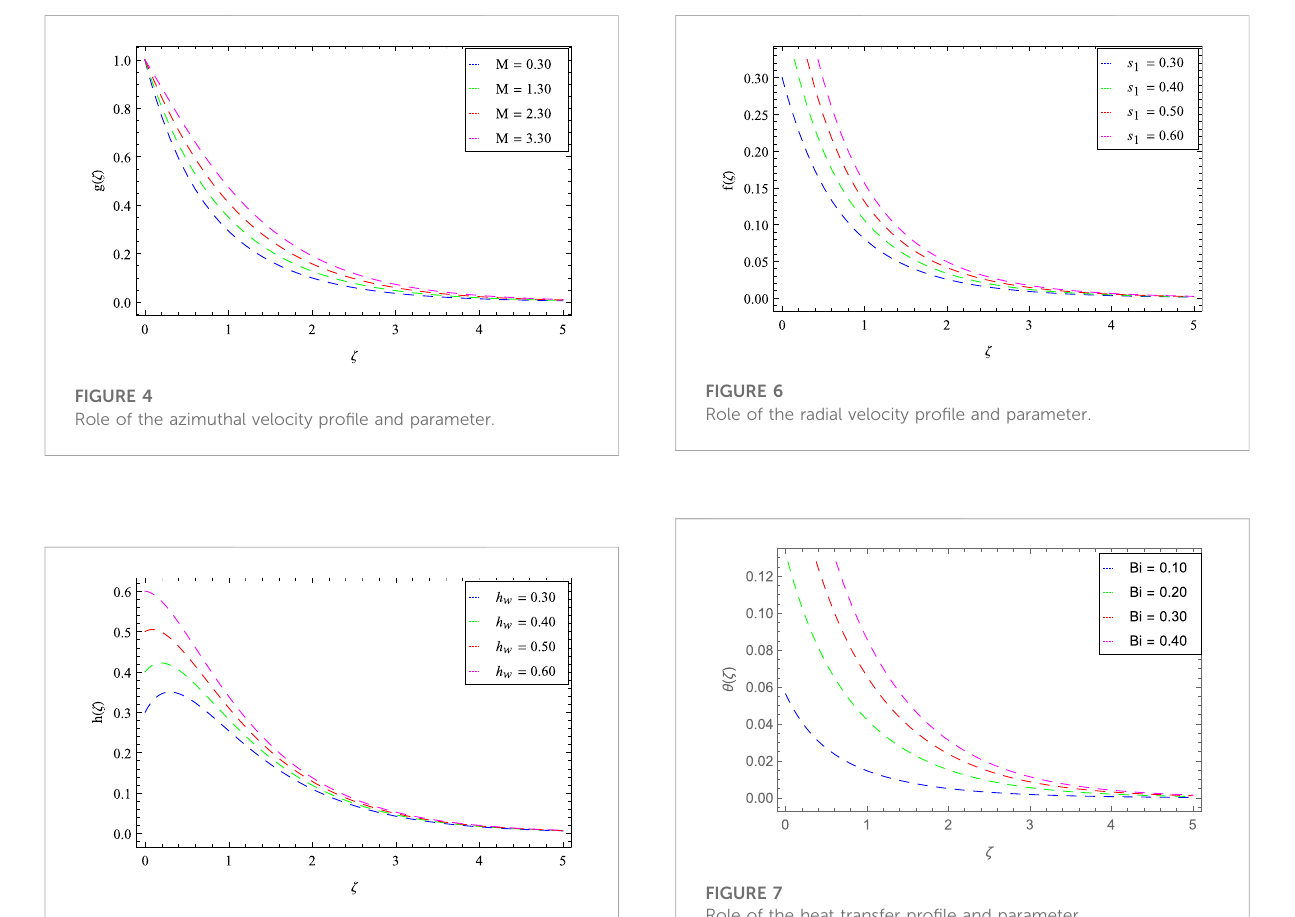
FIGURE 5 Role of the axial velocity pro fi le and parameter.